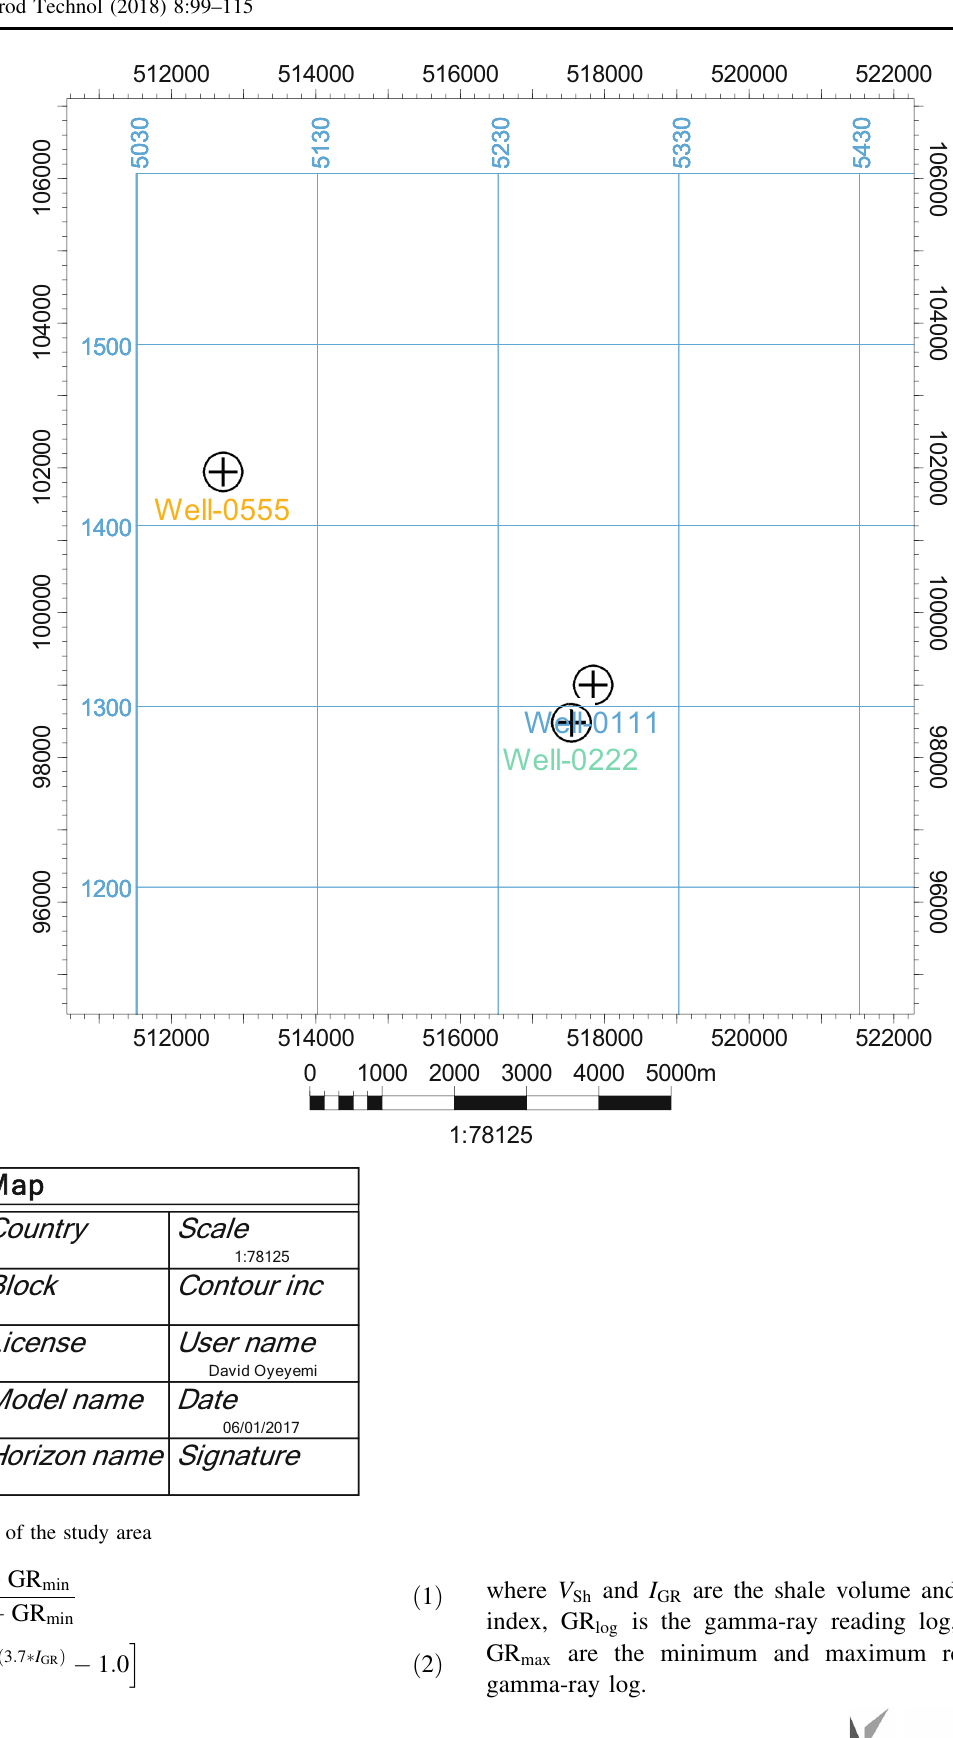
Fig. 3 Base map of the study